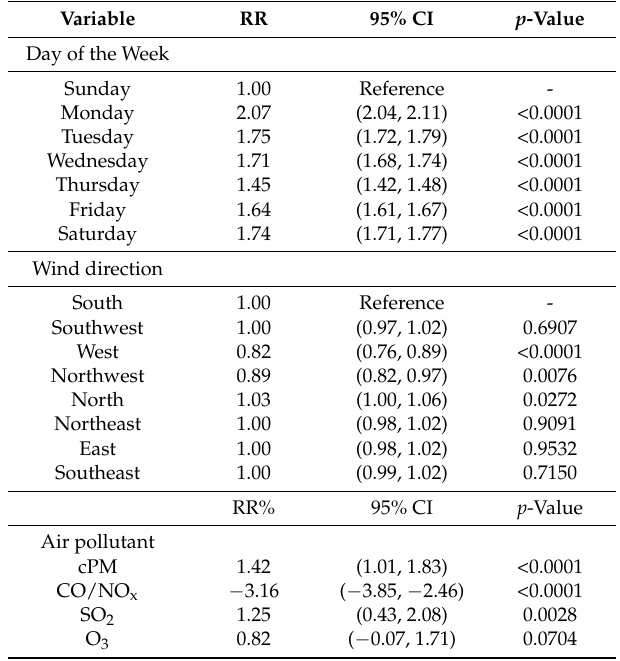
Table 2. Percentage change of relative risk (RR) in children’s clinic visits for asthma from 2005 to 2010.